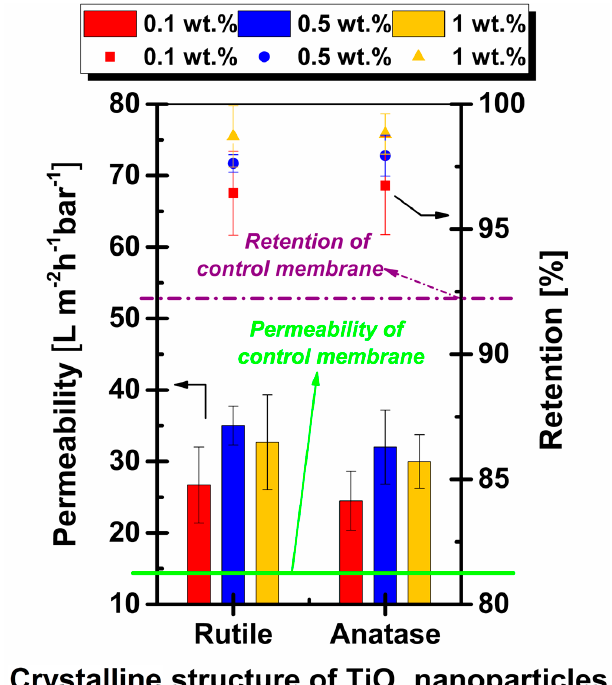
Figure 8. Permeability and retention of the control membrane and membranes with the addition of rutile and anatase nanoparticles at concentrations of 0.1 wt.%, 0.5 wt.% and 1 wt.%. The most significant difference, taking into account both crystalline structure and na ‐ noparticle concentration, occurred between the membranes with 0.5 wt.% TiO 2 . Rutile blended membranes achieved a permeability 9.4% higher than membranes modified with anatase nanoparticles. However, compared to the control membrane, the incorporation of 0.5 wt.% TiO 2 rutile and anatase nanoparticles into the polymeric solution led to increases in permeability of 139.7% and 119.2% respectively.